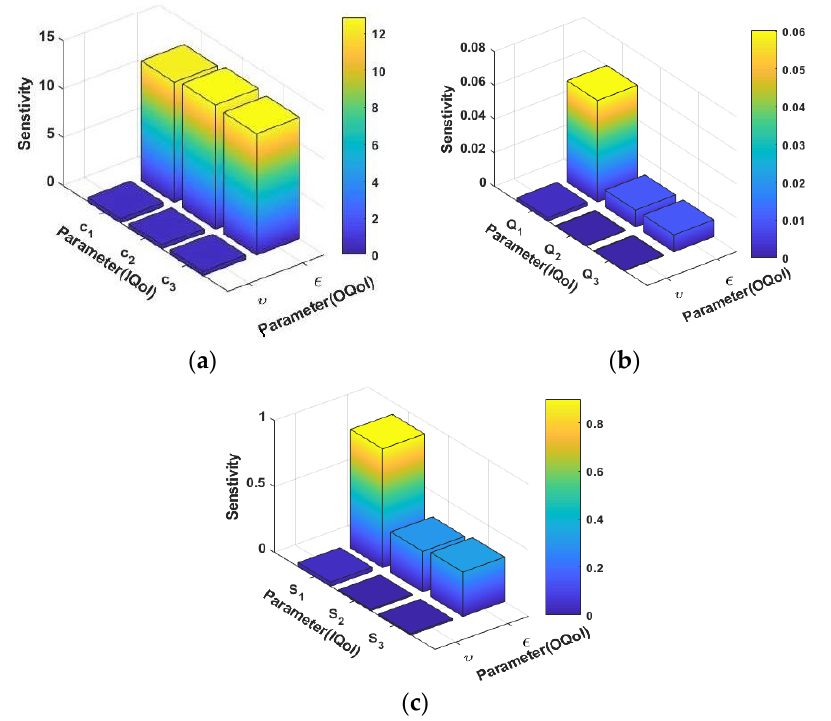
Figure 2. NLSA of the involved model parameter on the output QoI ( a – c ).